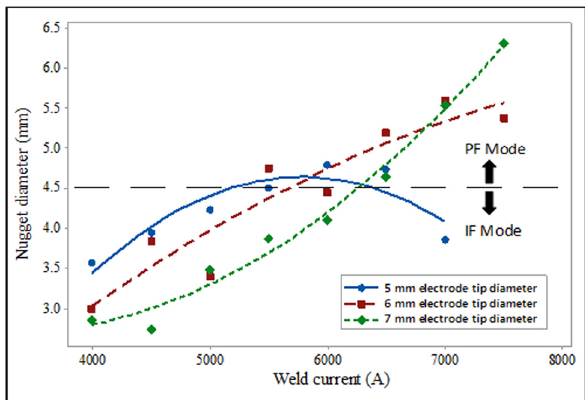
Figure 8: Effect of electrode tip diameter and welding current on nugget diameter and failure mode.